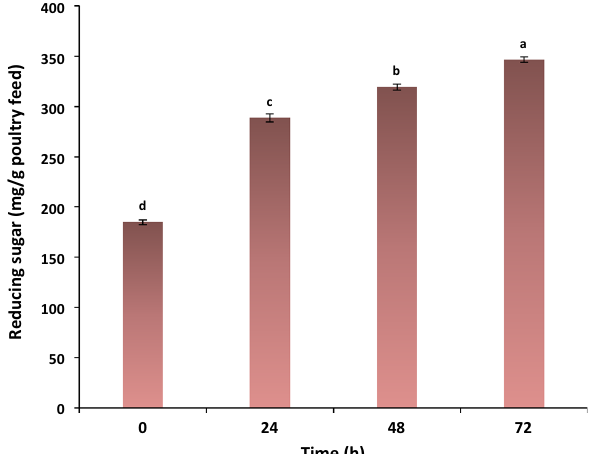
Figure 4. The amounts of reducing sugars during the poultry feed biodegradation with the enzyme cocktail after 72 h of hydrolysis at 50